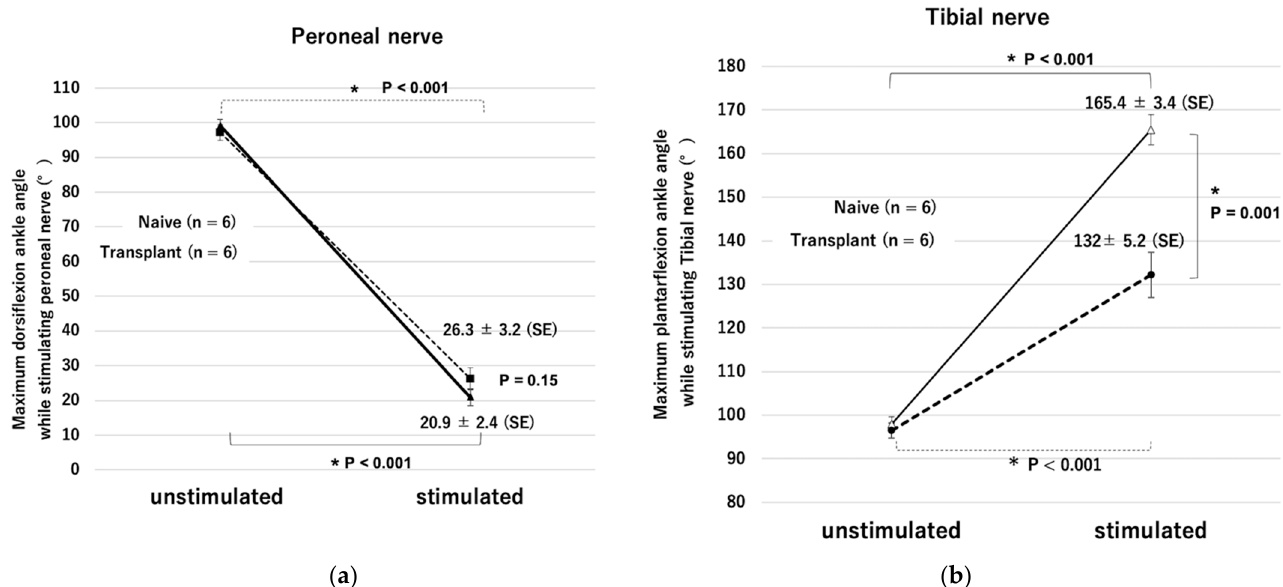
Figure 6. Amplitude of the compound muscle action potential (CMAP) of the ( a ) peroneal nerve and ( b ) tibial nerve. * p < 0.05.